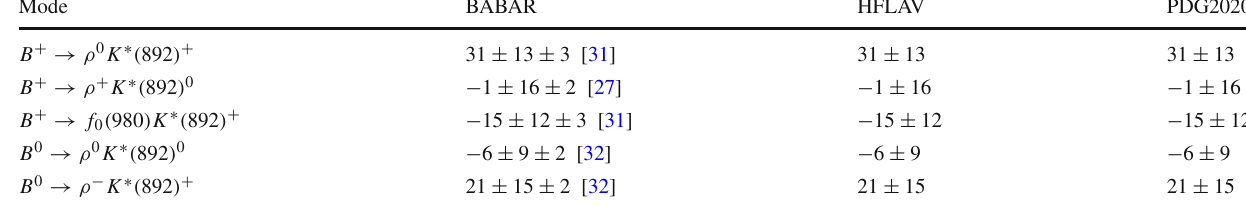
Table 2 Experimental CP asymmetries (in units of %) of B → (ππ)( K π) decays [45,46] Mode BABAR HFLAV PDG2020